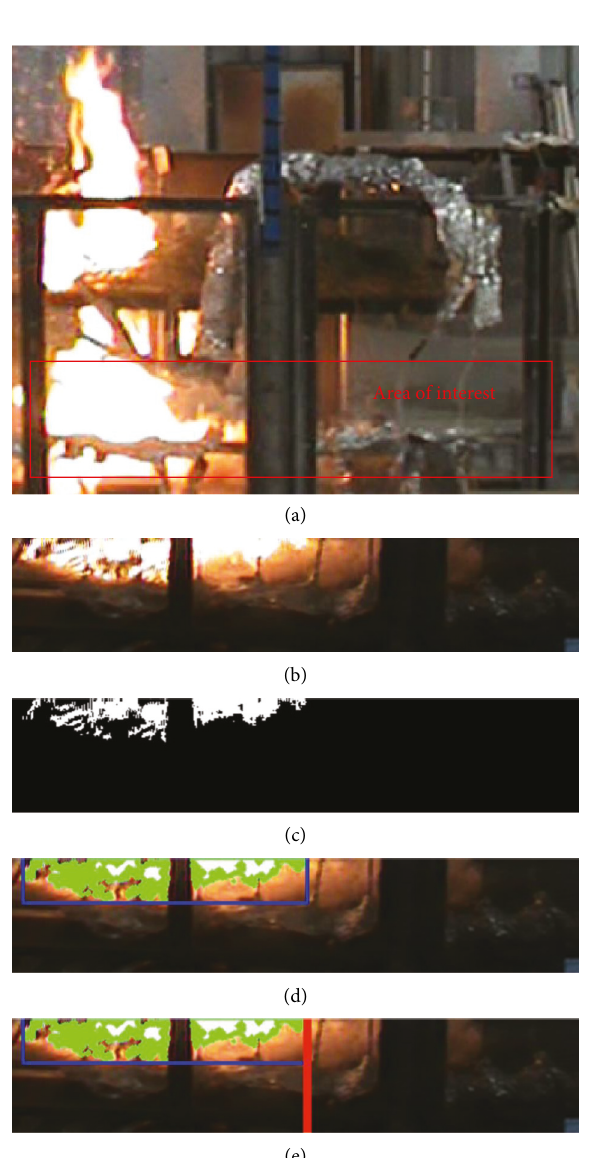
Figure 2: (a) Raw flame image. (b) Cropped flame region of in- terest. (c) Binary image. (d) Final bounding rectangle. (e) Iden- tification of leading edge.